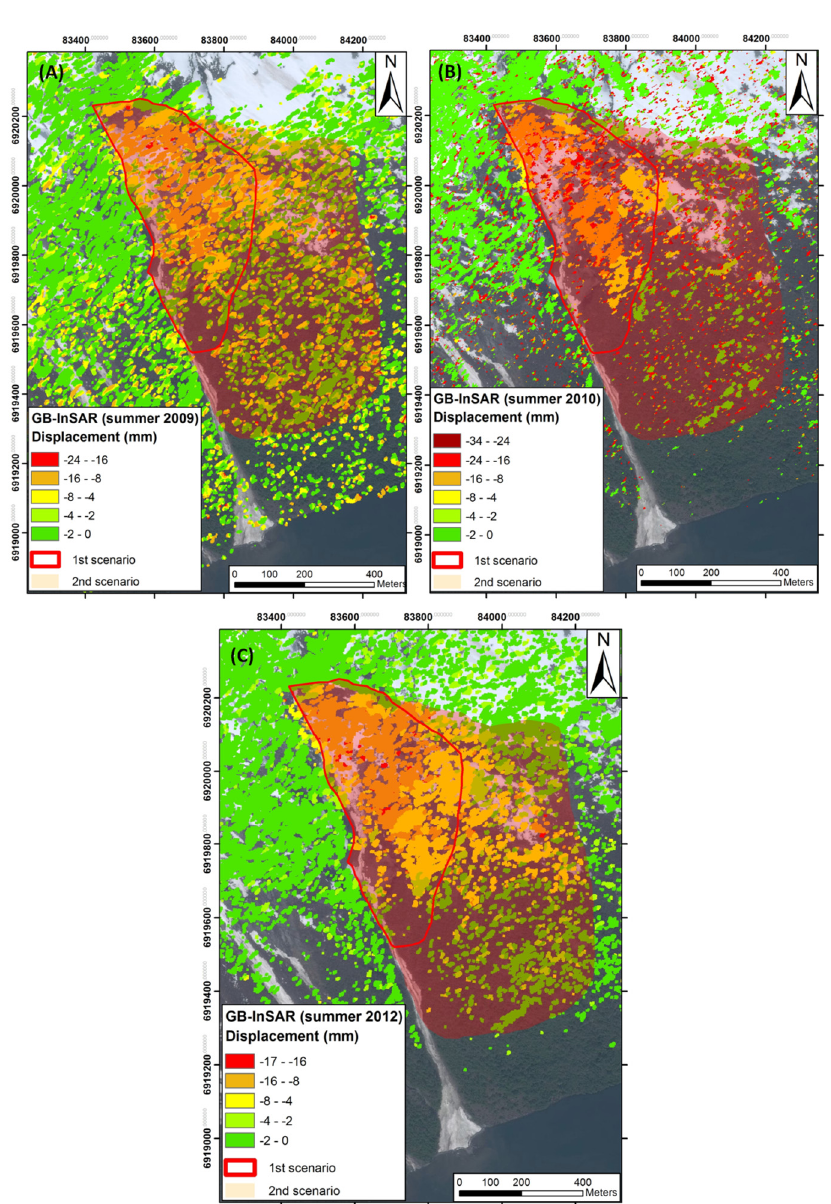
Figure 6. Cumulated displacement maps of GB-InSAR campaigns from Oaldsbygda. ( A ) Time interval of 108 days, between July and October 2009; ( B ) time interval of 114 days, between July and October 2010; ( C ) time interval of 104 days, between July and October 2012. Negative displacements represent movements approaching the sensor.